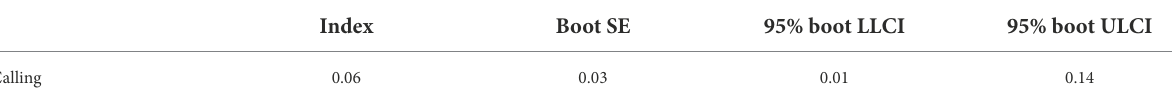
TABLE 4 The index of moderated mediation.